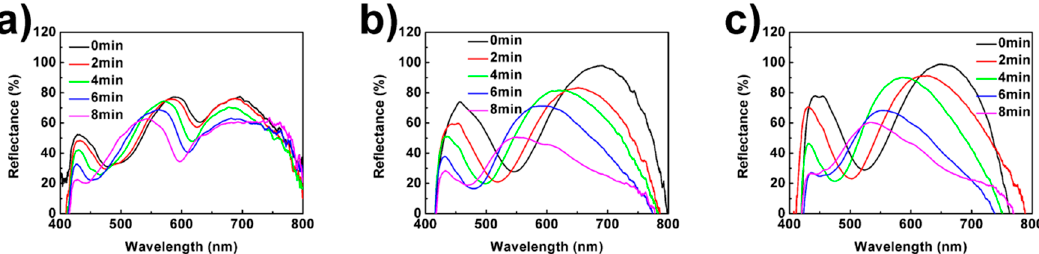
Figure 3. Optical properties of the fabricated structures:( a ) reflectance spectra of the ncp MCCs-x obtained at different etching times (x = 0, 2, 4, 6, 8 min); ( b ) reflectance spectra of the qP2VP-infiltrated